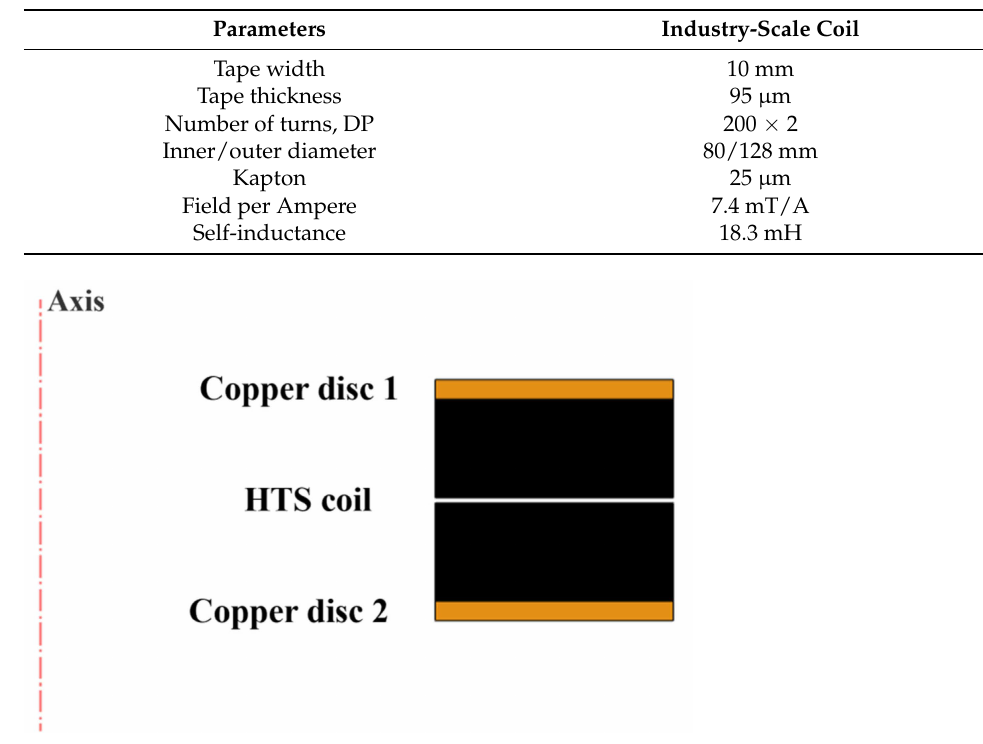
Figure 5. Schematic illustration of the HTS DP coil and two copper discs in 2D axisymmetric space.